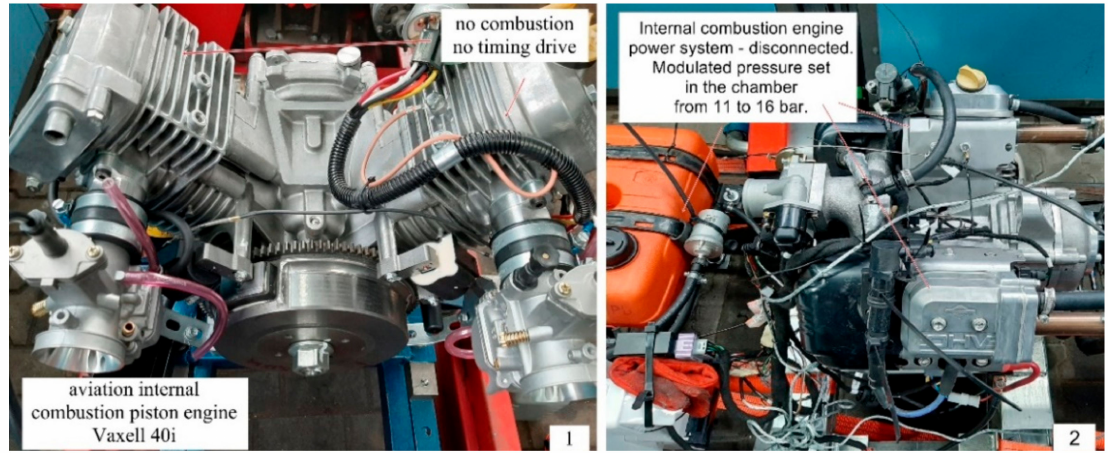
Figure 2. The view of the test stand and the engine torque sensor mounted on it. The stand ensures the accuracy of the regulation and measurement of the rotational speed of the engine crankshaft at the level of ± 1.0 rpm. Based on the average of 5 measure- ments of the engine rotational speed, temperature, oil viscosity and geometric dimensions of the engine, the mean values of the moment of resistance to motion were obtained, which were the basis for the results of the primary measurements. The maximum standard devia- tion of the measurement results did not exceed ± 1.0%. The data of the aircraft engine on the dynamometer are presented in Table